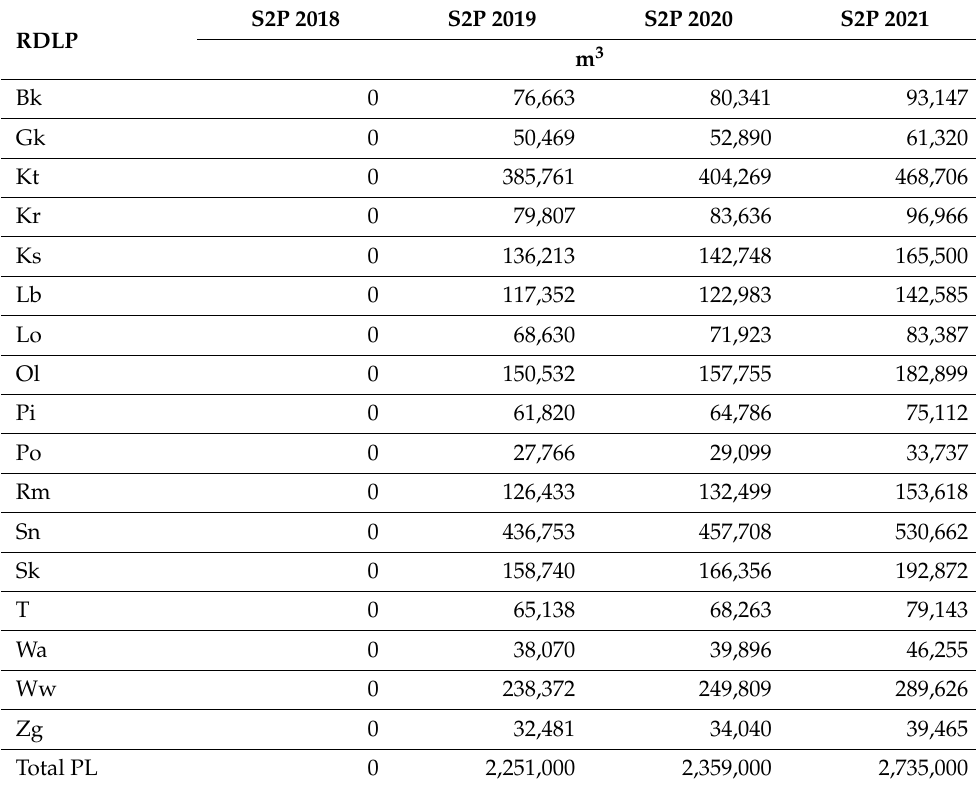
Table 10. Change in the structure of S4w wood biomass from